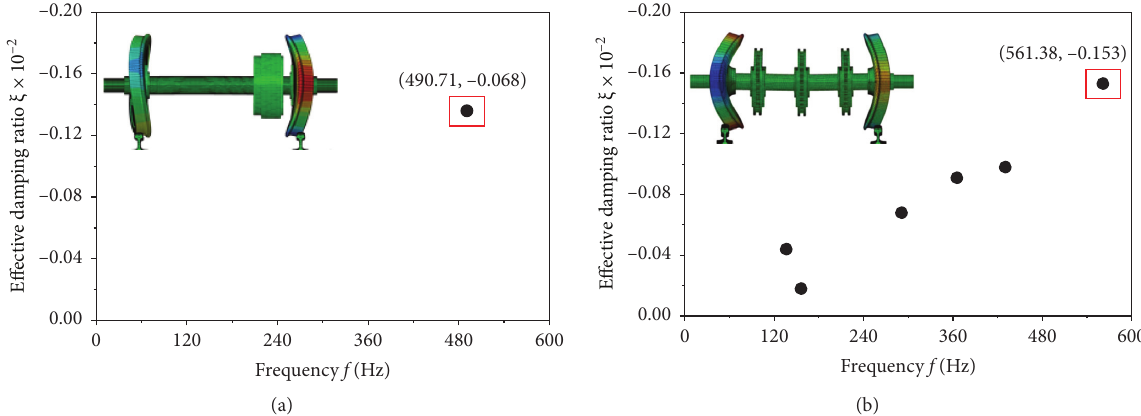
Figure 9: Frequency distributions of frictional self-excited vibration of wheelset-track system with the brake coupling: (a) the power wheelset and (b) the trailer wheelset.